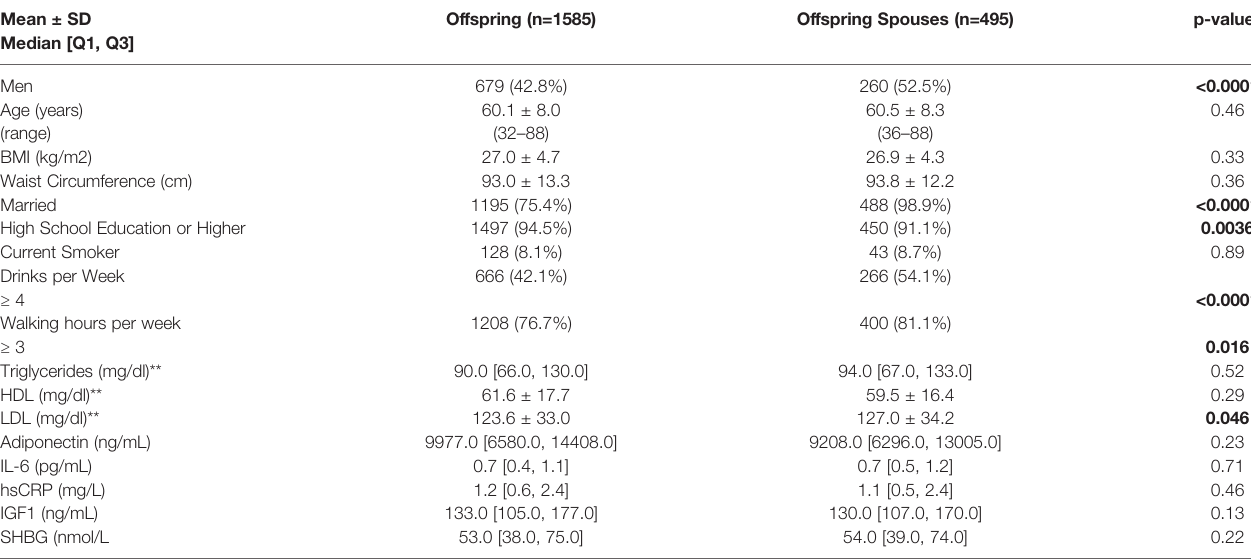
TABLE 1 | Selected baseline characteristics of LLFS offspring and their spouses without